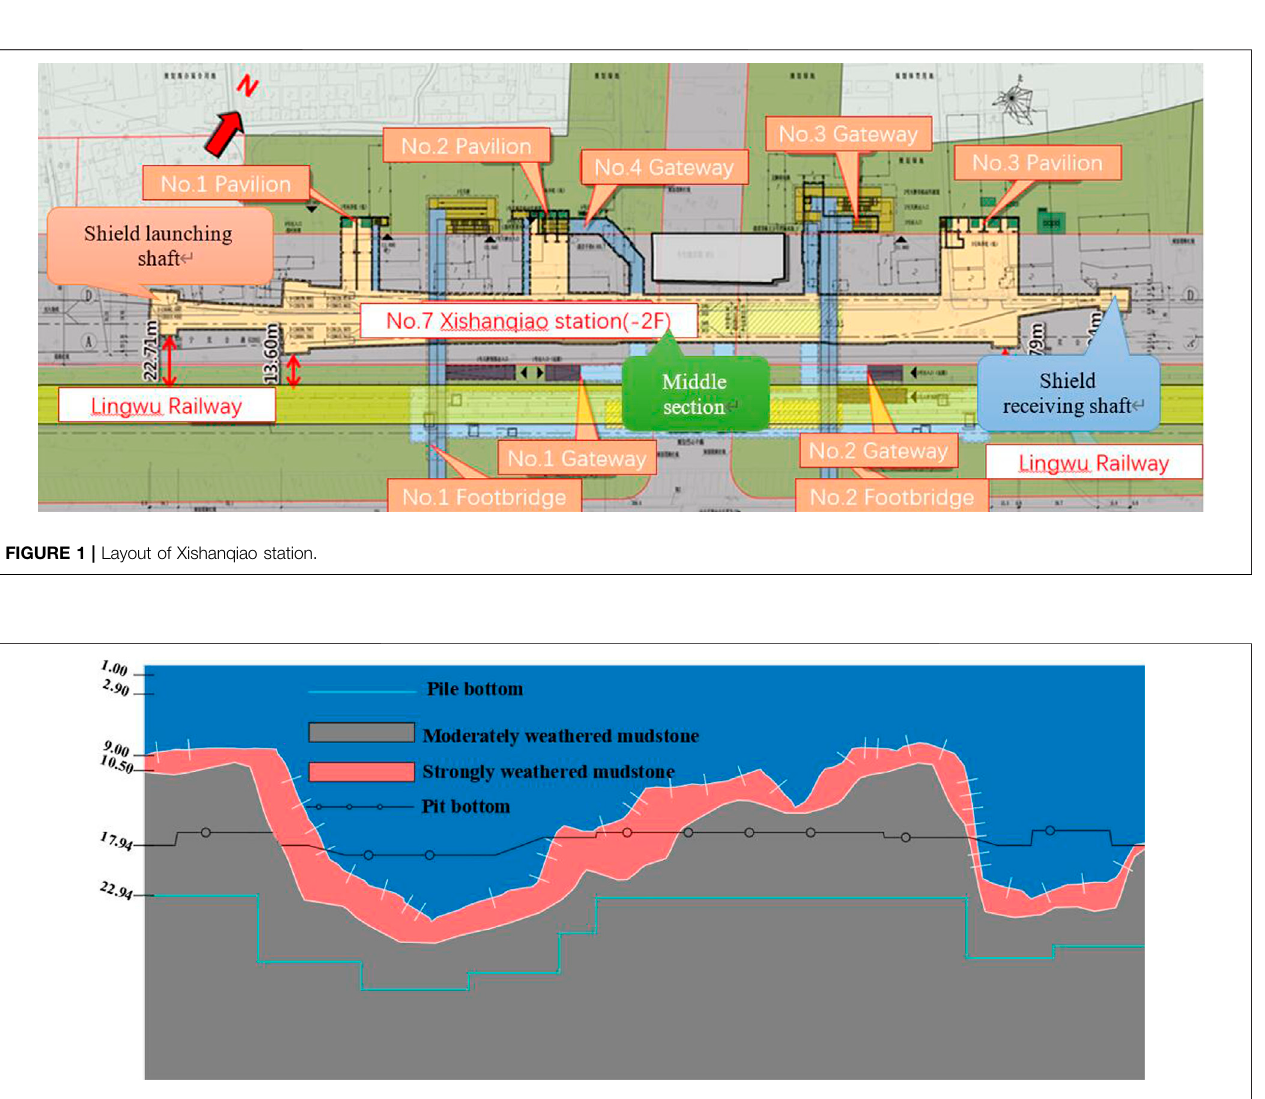
layer of the piles are all in a “ convex ” type distribution. The black line in Figure 5 represents the deeper rock-socketed depth (10 – 12 m), and the corresponding maximum horizontal displacement values of the rock-socketed support piles are mostly between 0.2 ‰ H – 0.55 ‰ H , with an average value of